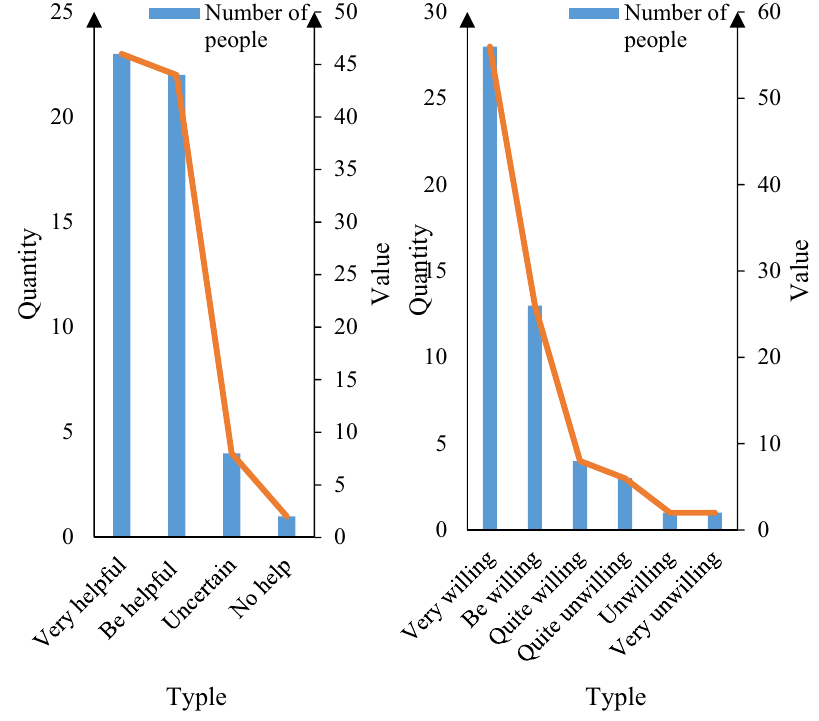
(a) Helpfulness to students’ understanding (b) Willingness to apply to other